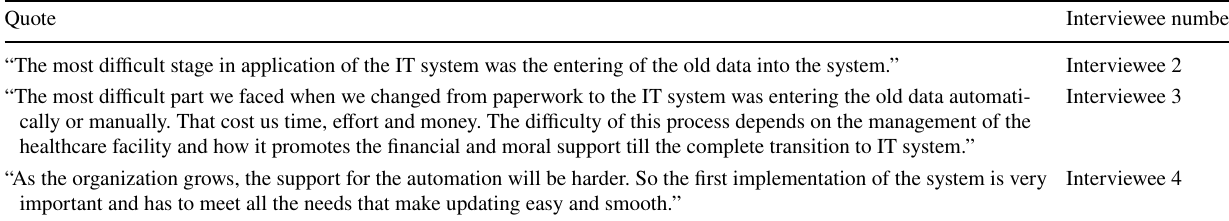
Table 5 Barriers to IT implementation in healthcare settings due to IT implementation